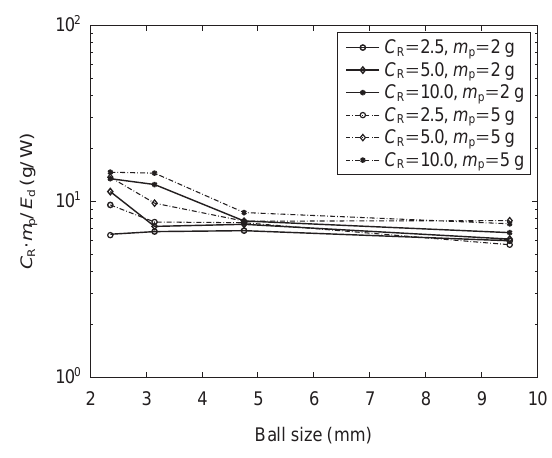
Theoretical/numerical milling dose D m based on the head- on energy dissipation rate as a function of ball